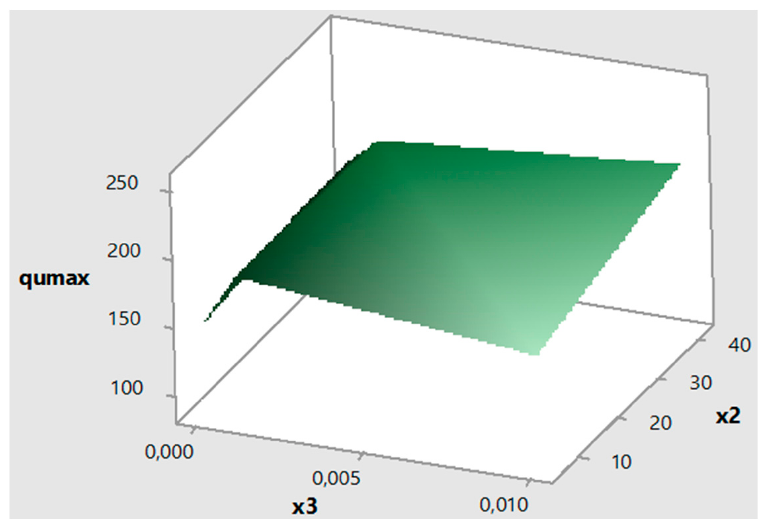
Figure 6. Surface plot of q u max vs. x2 and x3.